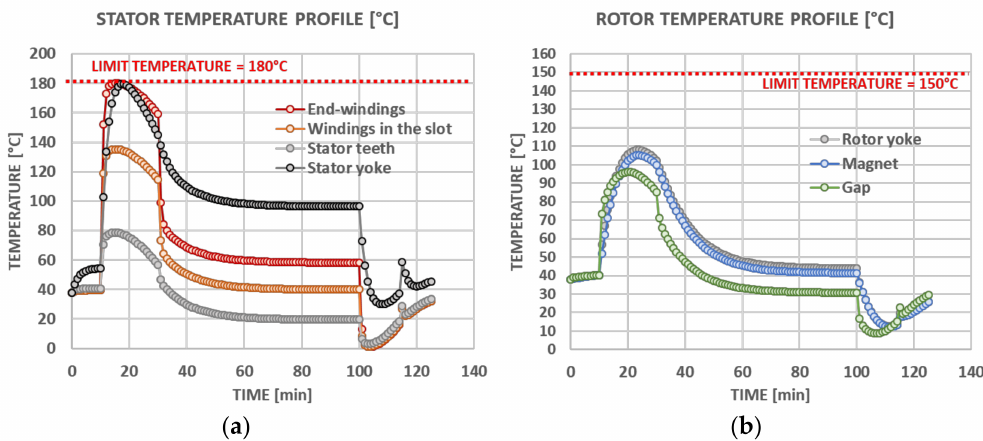
Figure 19. e-Motor temperature with the external and internal cooling system over the mission. ( a ) Stator side, and ( b ) rotor